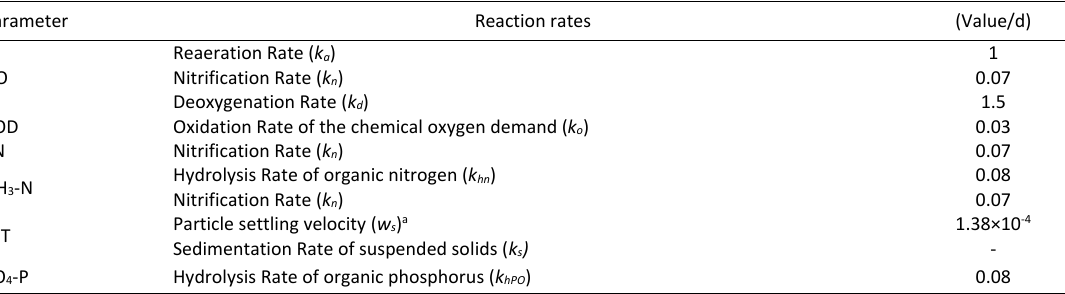
Table 5: Main modified coefficients in the water quality component